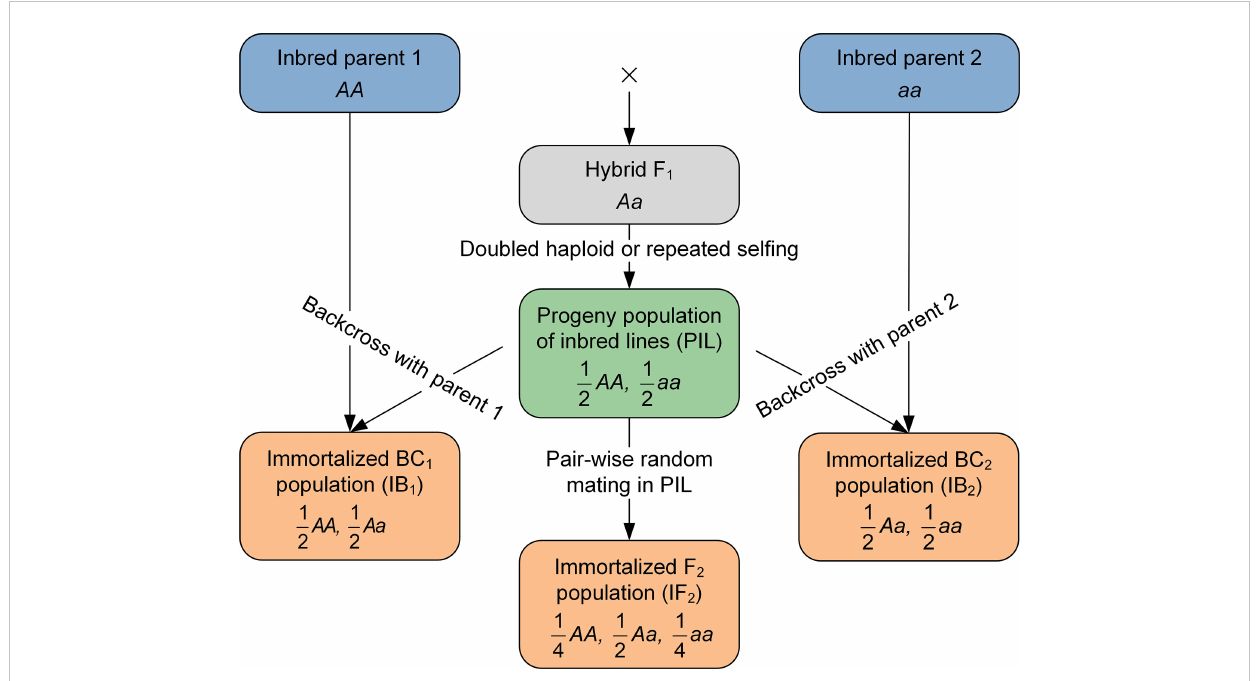
FIGURE 1 Diagram of the development procedure of immortalized backcross and immortalized F 2